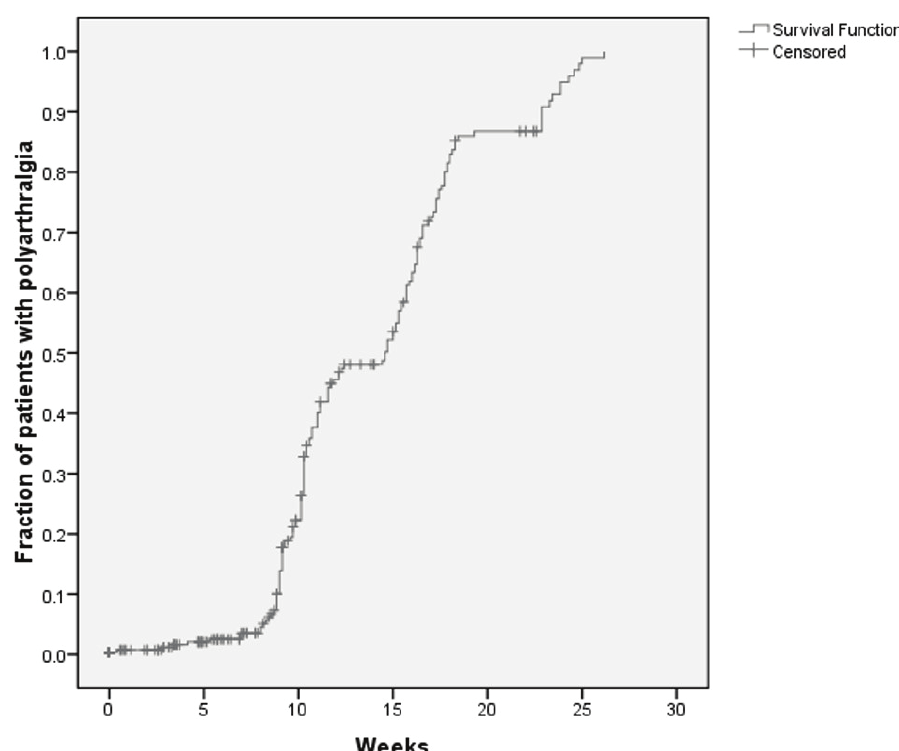
Figure 2. Kaplan-Meier curve of the cumulative prevalence of pCHIK-CPA by follow-up time.